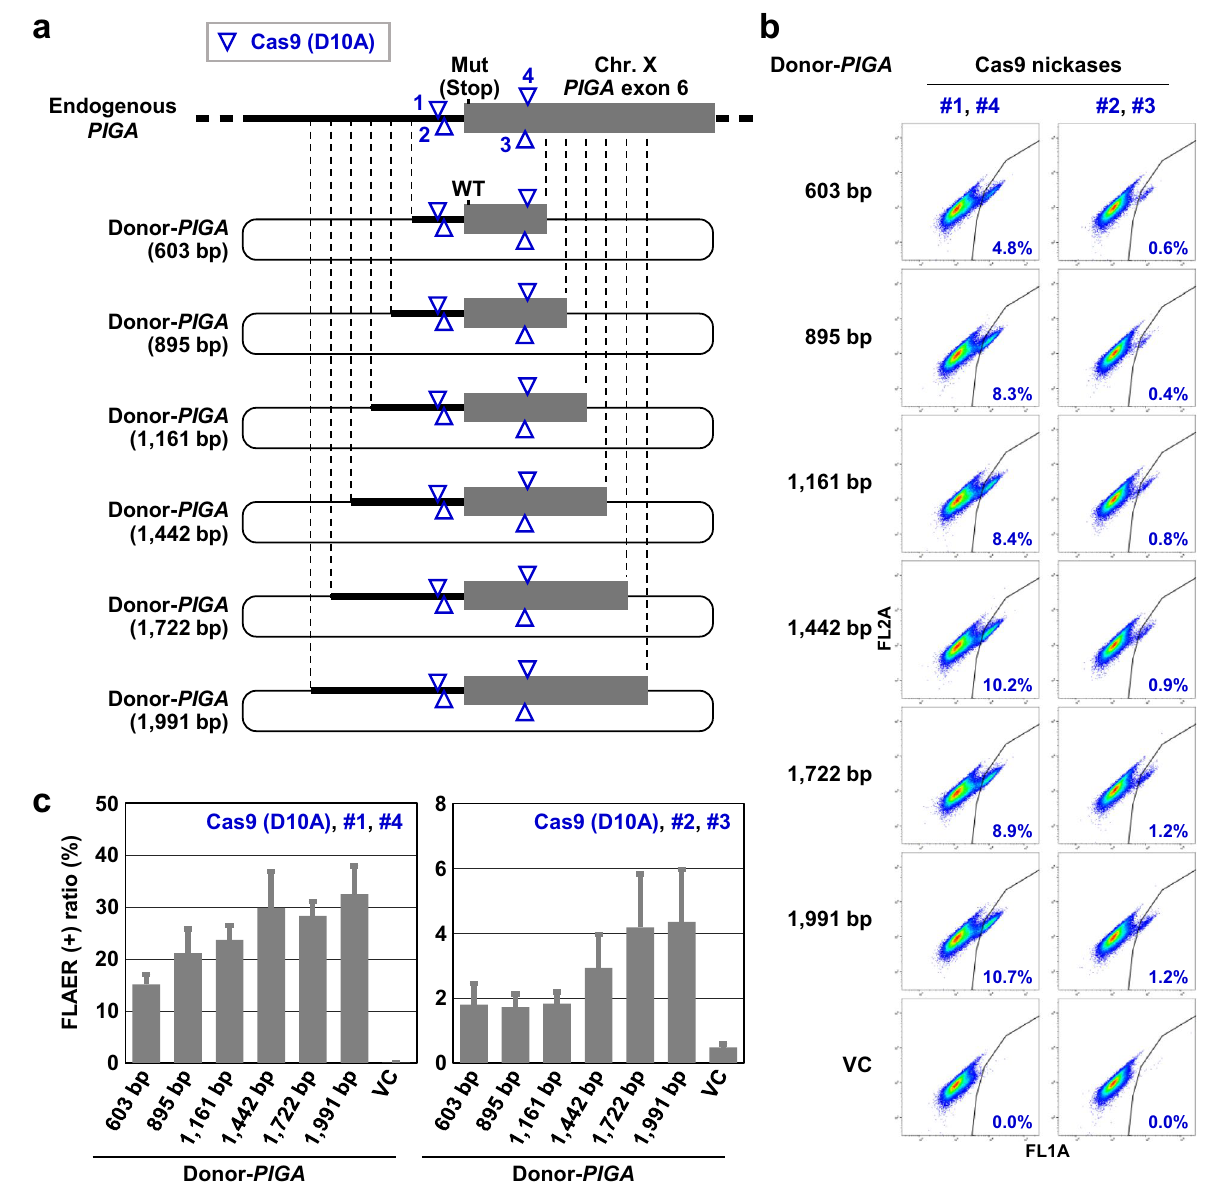
Figure 1. Efficient targeted knock-in via TPN is supported by 1700–2000-bp donor DNAs. (a) Donor plasmids carrying various lengths of homology with a genomic region surrounding the human PIGA intron 5/exon 6 boundary. The lengths of homology in respective donor plasmids (Donor- PIGA ) are noted in parentheses. Numbers from 1 through 4 indicate distinct Cas9 nickases and correspond to #1 through #4 in ( b , c ). Hereinafter, bold lines and gray boxes in schematic representation indicate portions of PIGA intron 5 and exon 6, respectively, unless otherwise noted. Thin and dotted lines indicate backbones in plasmids and homologous regions, respectively. Mut (Stop): a nonsense mutation; WT: wild-type sequence. (b) Representative dot graphs obtained from FCM analyses. Percentages of FLAER-positive cells are denoted in the graphs. VC represents a vector control. Hereinafter, FL1A and FL2A indicate fluorescence signals measured at 530 ± 15 nm and 585 ± 21 nm, respectively, under 488-nm laser excitation. (c) Graphical representation of the results. Data represent mean and SEM values from three independent